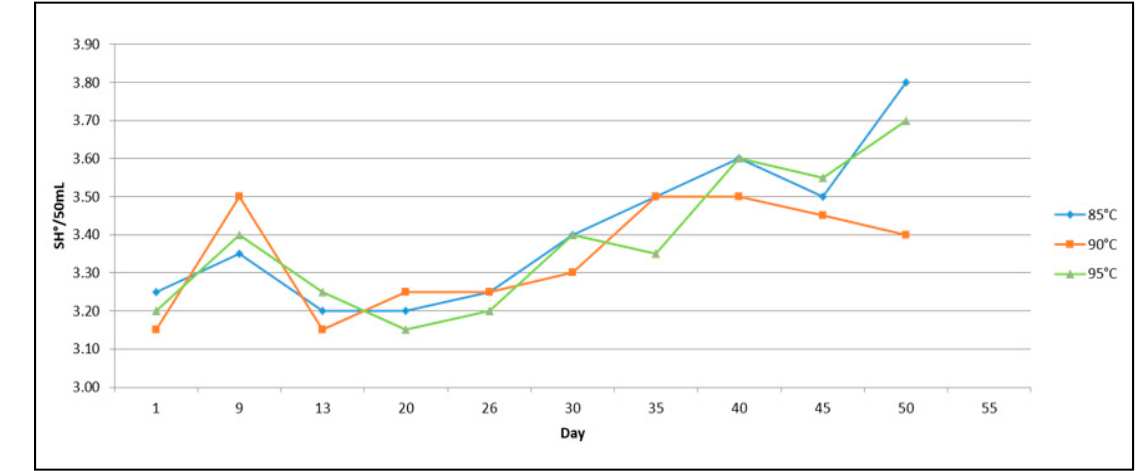
Figure 7. Measurements of acidity during a storage period of 55 days at 4 °C.